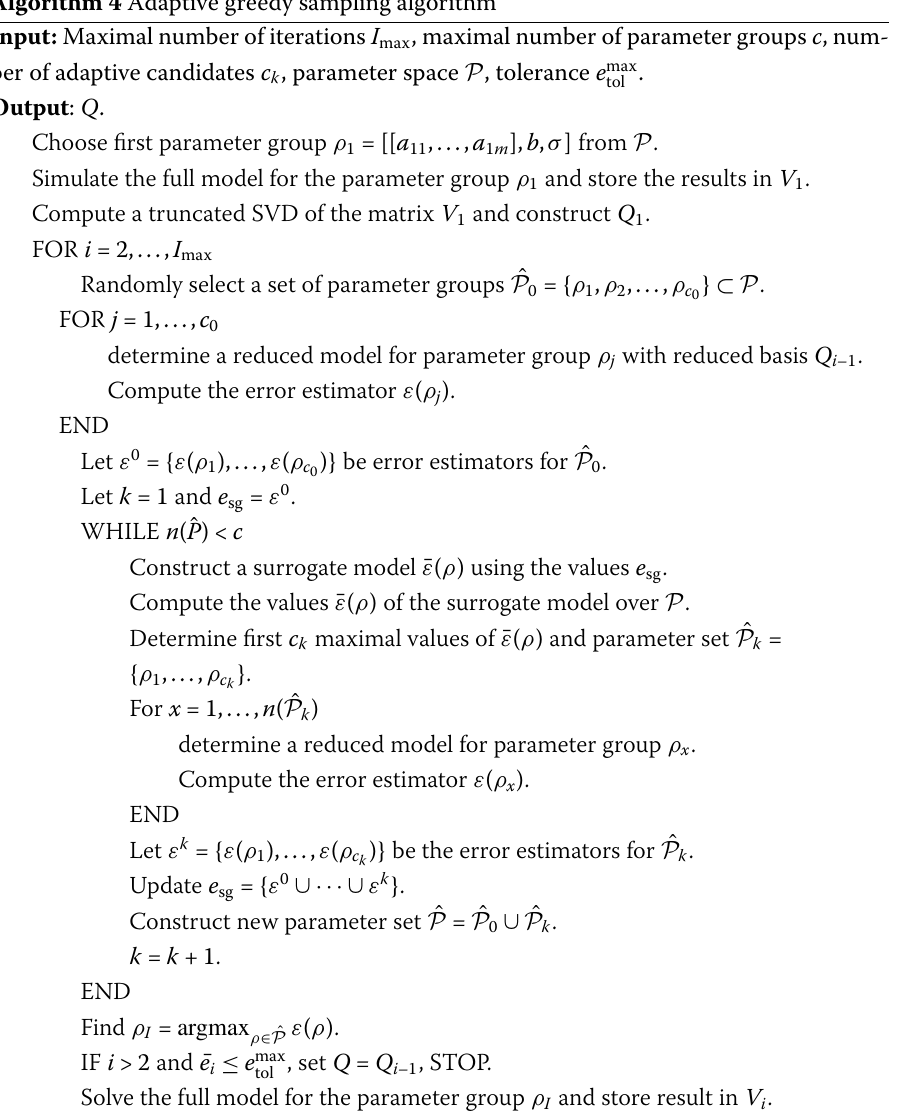
Algorithm 4 Adaptive greedy sampling